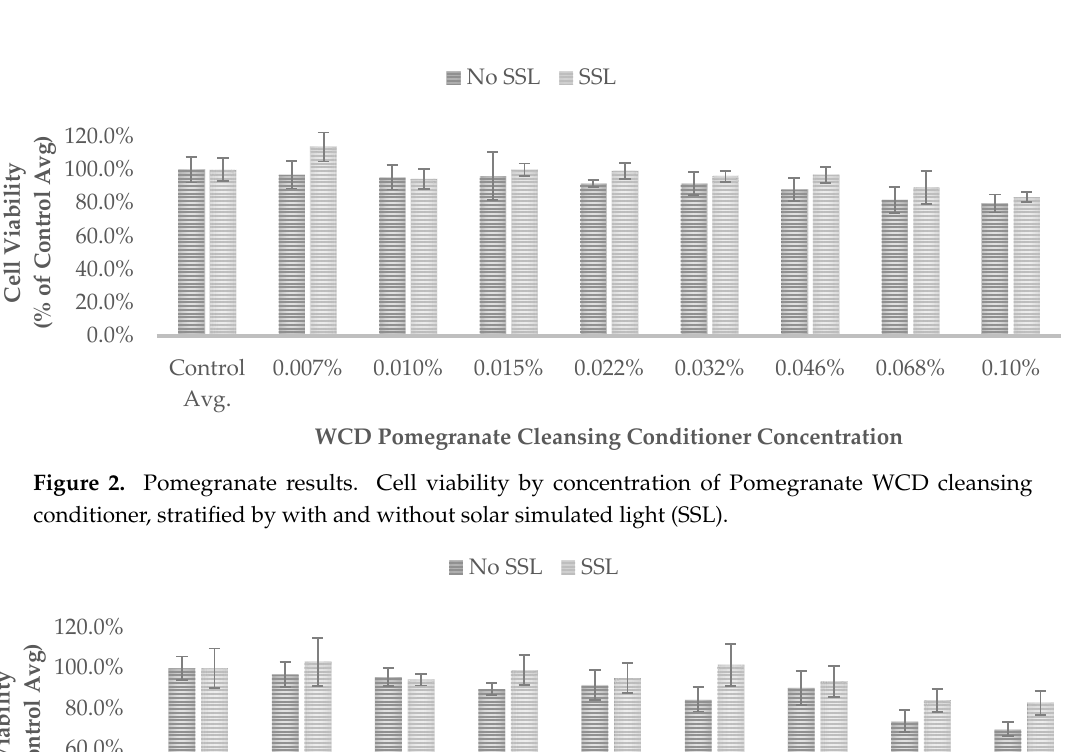
Figure 1. Lavender results. Cell viability by concentration of Lavender WCD cleansing conditioner, stratified by with and without solar simulated light (SSL).